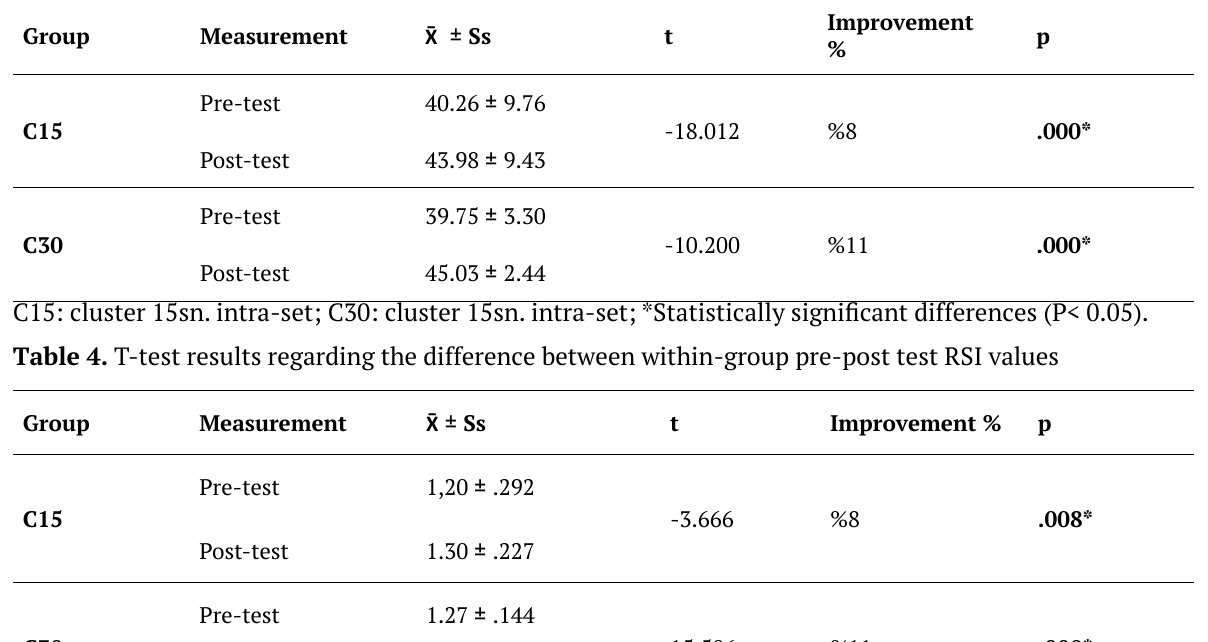
Table 3. T-test results regarding the difference between within-group pre-post test CMJ values Group